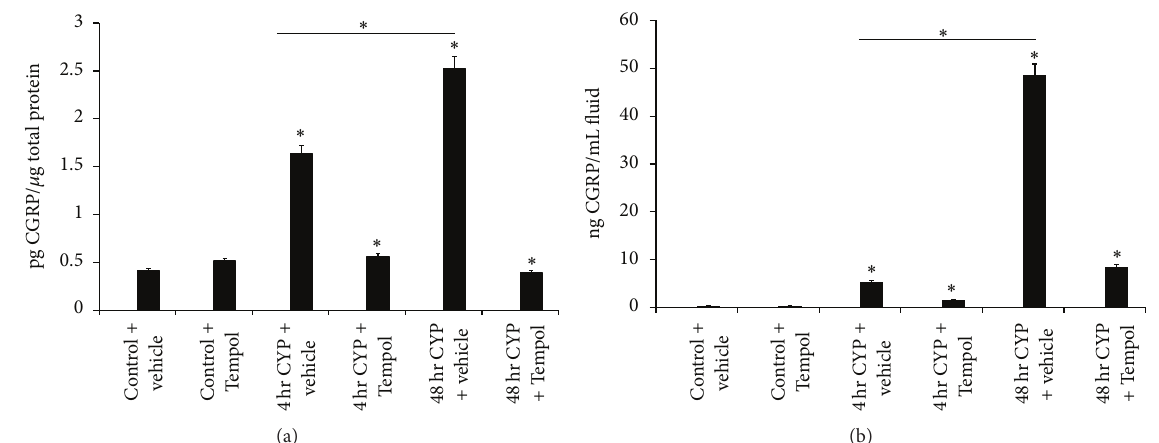
Figure 3: Cyclophosphamide- (CYP-) induced cystitis increases calcitonin gene-related peptide (CGRP) in the urinary bladder and cystometric fluid and the antioxidant, Tempol, reduces expression. (a) 4 hr and 48hr CYP-induced cystitis significantly ( 𝑃 ≤ 0.01 ) increased CGRP expression in urinary bladder that was significantly ( 𝑃 ≤ 0.01 ) reduced with Tempol. Tempol was without effect on CGRP expression in urinary bladder from control (no CYP) rats. (b) 4 hr and 48hr CYP-induced cystitis significantly ( 𝑃 ≤ 0.01 ) increased CGRP expression in cystometric fluid that was significantly ( 𝑃 ≤ 0.01 ) reduced with Tempol. ∗ 𝑃 ≤ 0.01 . 𝑛 = 6 for control and treatment groups.